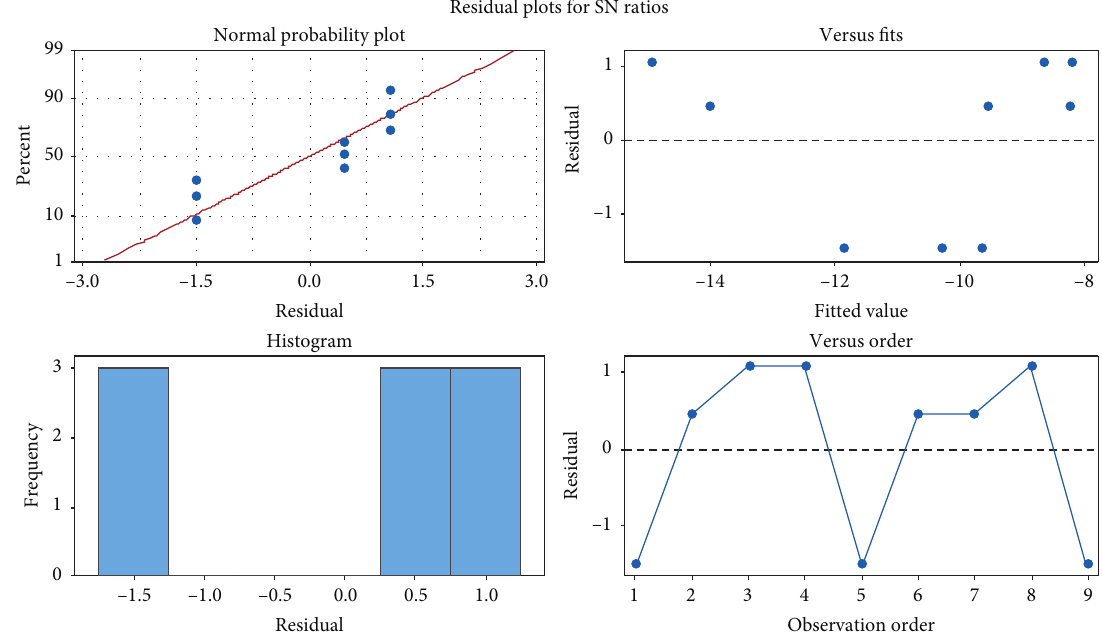
Figure 7: Surface roughness on machined surface residual plot of percent, frequency, fitted values, and versus order.